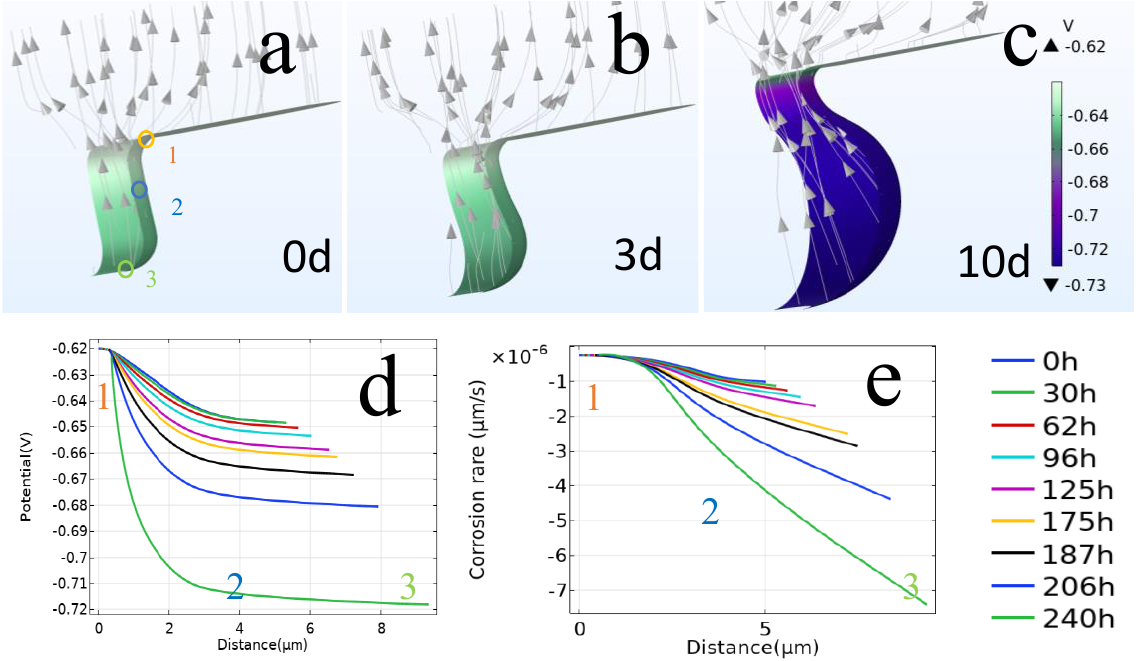
Figure 9. Calculated relative changes of local metal potential at different times. ( a – c ) potential distribution clouds at 10 h, 90 h, and 240 h, respectively, ( d ) relative changes of local potential of the metal surface along the y-direction, and ( e ) the corrosion rate distribution along the y-direction.